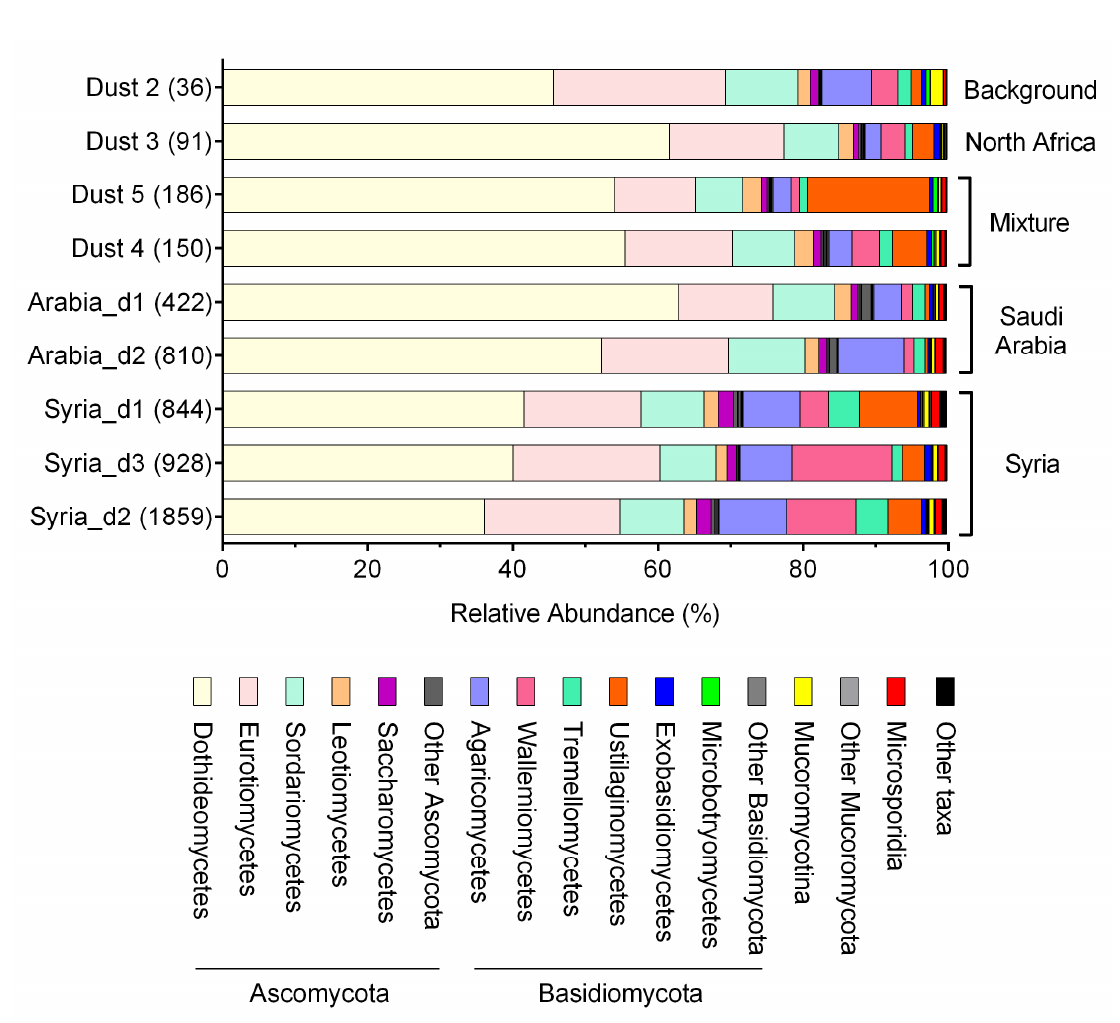
Figure 3. The relative abundance of fungal reads classified by DIAMOND at the class level (except for Mucoromycotina and Microsporidia) in aerosol samples. The numbers in the parenthesis behind the sample number represent PM10 concentrations in µ g m − 3 . The origin of the samples is marked to the right of the stacked bars. Sample “Dust 4” includes a mixture of aerosols originated from North Africa and Saudi Arabia. Sample “Dust 5” includes a mixture of aerosols originated from North Africa, Jordan, and Sinai